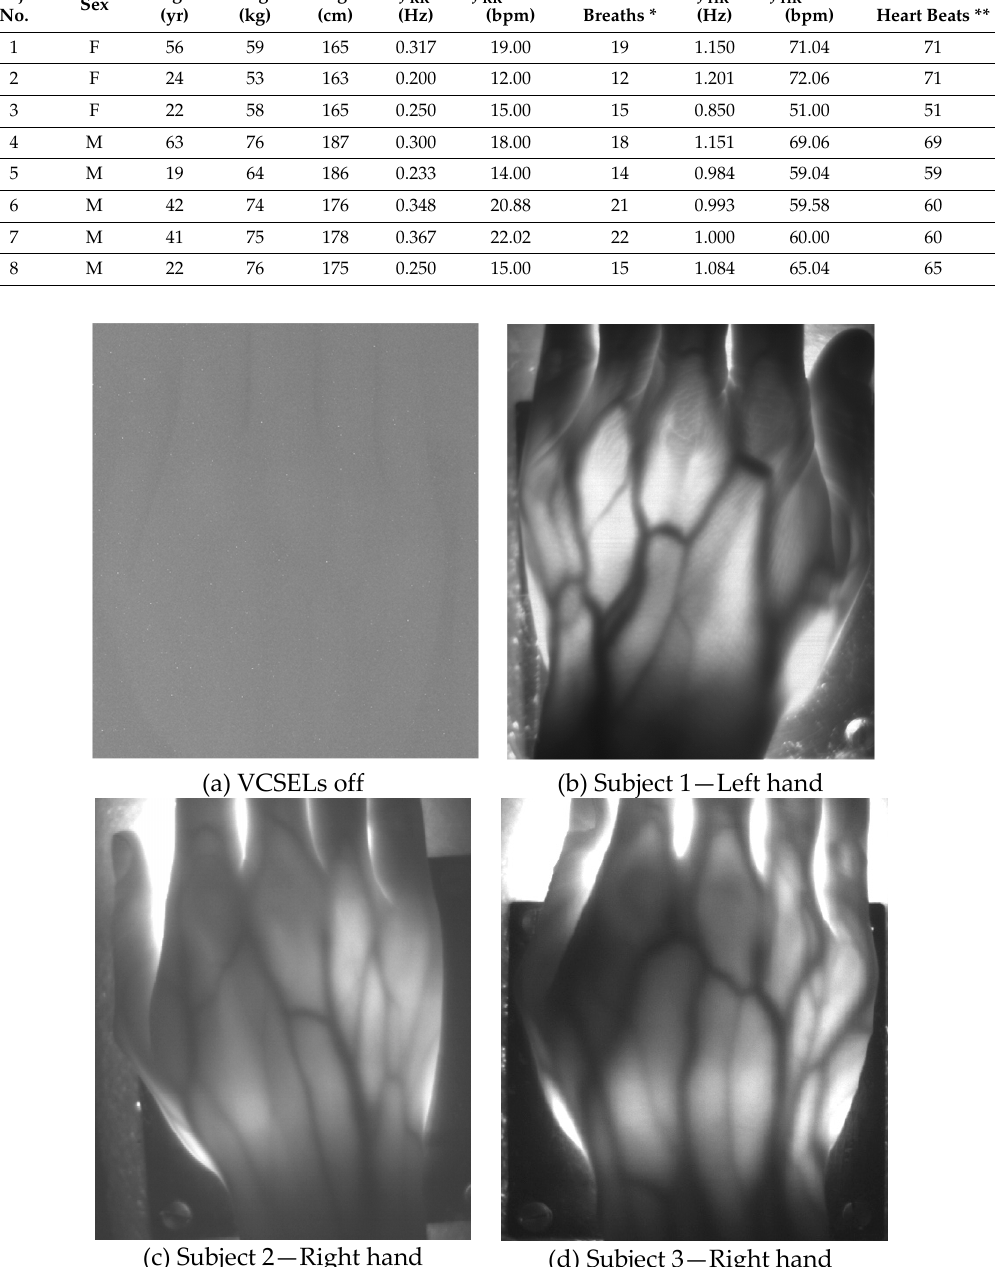
Table 1. Summary of tested subjects. * number of breaths counted in a minute; ** number of heart beats counted in a minute. Subjects 1 to 7 have white skin. Subject 8 has dark skin.